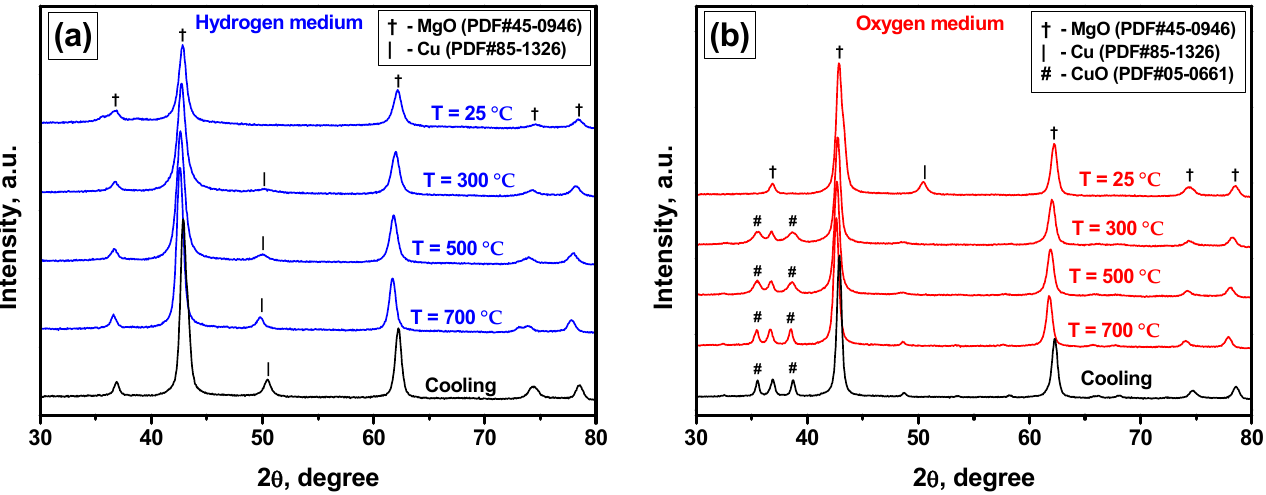
Figure 6. XRD patterns of the Cu-Mg-O system recorded in an in-situ regime at hydrogen ( a ) and oxygen ( b ) atmospheres. Table 2. Quantitative characteristics (average size of crystallites <D>; the lengths a, b, and c of the three cell edges meeting at a vertex, and the angle β between edges a and c) obtained from the XRD data.